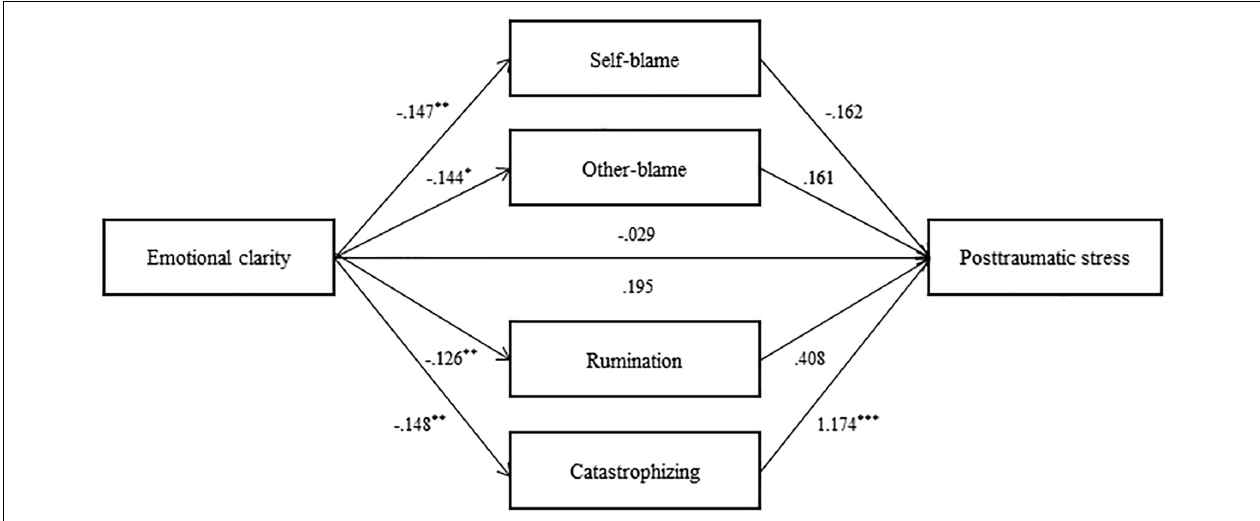
FIGURE 1 | Mediation model of maladaptrve emotion regulation strategies. Unstandardized coefficient values. * p < 0.05, ** p < 0.01, *** p < 0.001.